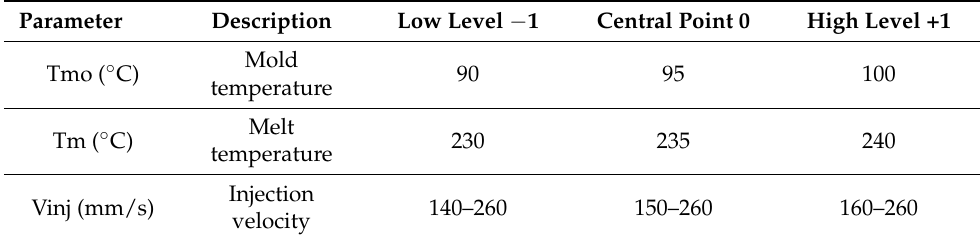
Table 4. Case B: process parameters setting.